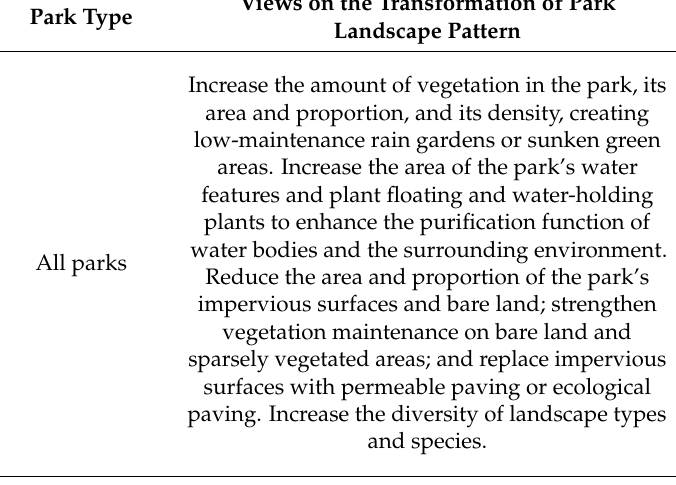
Table 3. Patterns of the best and worst parks for LST regulation and the renewal of parks with poor effect on mitigating urban thermal environment. Pattern